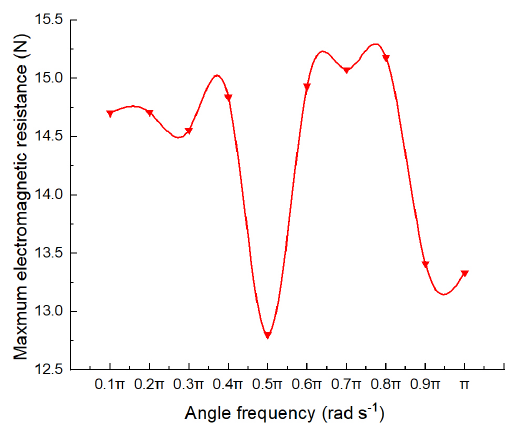
Figure 13. Influence of different angular frequencies on the maxi- mum value of electromagnetic resistance.